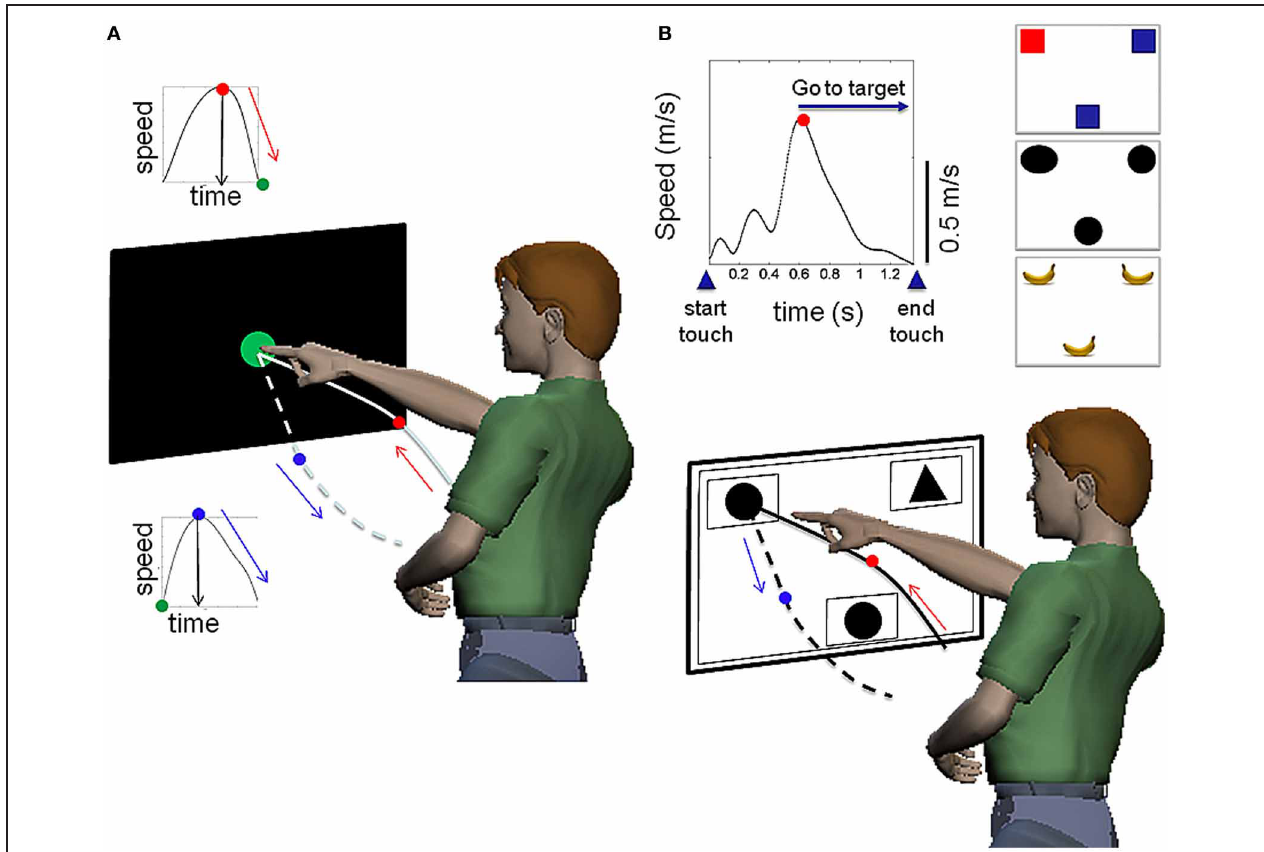
FIGURE 3 | Two variants of the pointing task to examine goal-directed and incidental goal-less movements in closed loop with decision-making processes. (A) Variant 1: basic pointing task, measuring the goal-directed motion to touch a target on the touch screen and spontaneous retraction away from it. The arrows mark the flow of motion. The speed profiles are also plotted as insets, with the dot marking the peak velocity and the arrow marking the time at which the peak is attained. (B) Variant 2: decision-making pointing during a